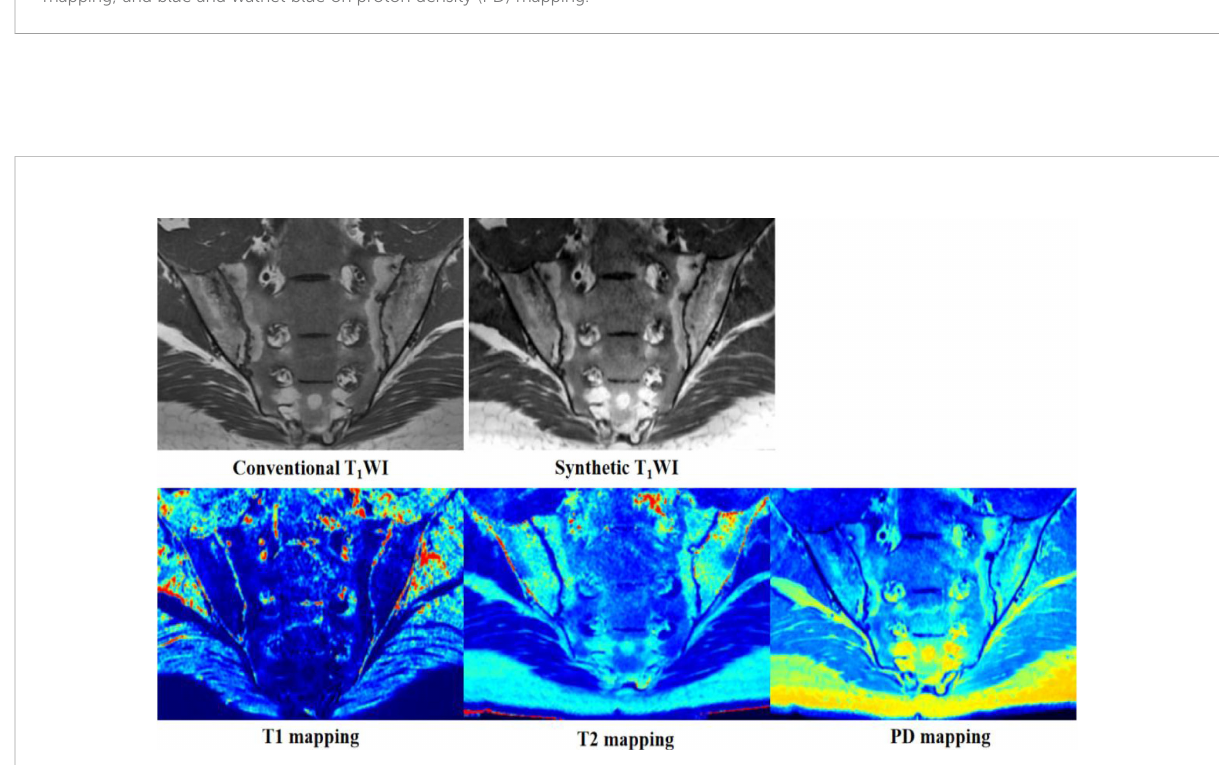
FIGURE 5 Images from a 29-year-old man with axial spondyloarthritis (axSpA) who presented with a 5-year history of in fl ammatory back pain and who was human leukocyte antigen B27 (HLA-B27) positive. Conventional and synthetic T1WI images show severe fat metaplasia in the bilateral sacroiliac joints. The corresponding areas are blue on T1 mapping; green, yellow, and red on T2 mapping; and wathet blue or green-yellow on proton density (PD)